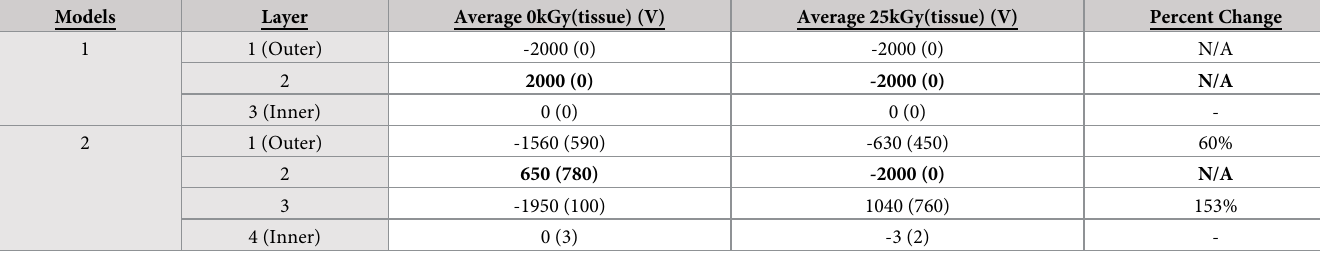
Standard deviation given in parenthesis.